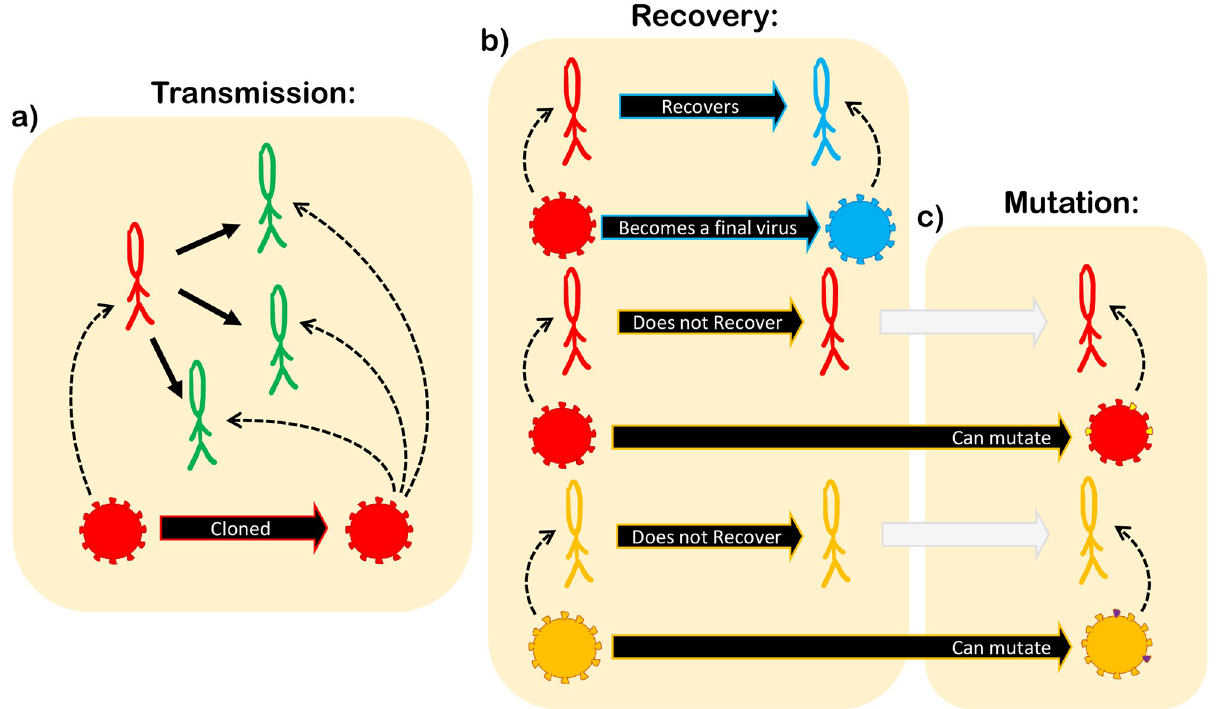
Fig 1. Model dynamics. (a) infected individuals (red) can transmit the virus to their susceptible first neighbors (green). When transmission is successful the virus is cloned to the new host, which is now an exposed individual (yellow) and will be able to mutate only in the next iteration. (b) infected individuals can recover with probability p R . When an individual recovers (blue), its virus stops mutating and becomes a “final virus.” (c) viruses on infected (red) or exposed (yellow) individuals can mutate.